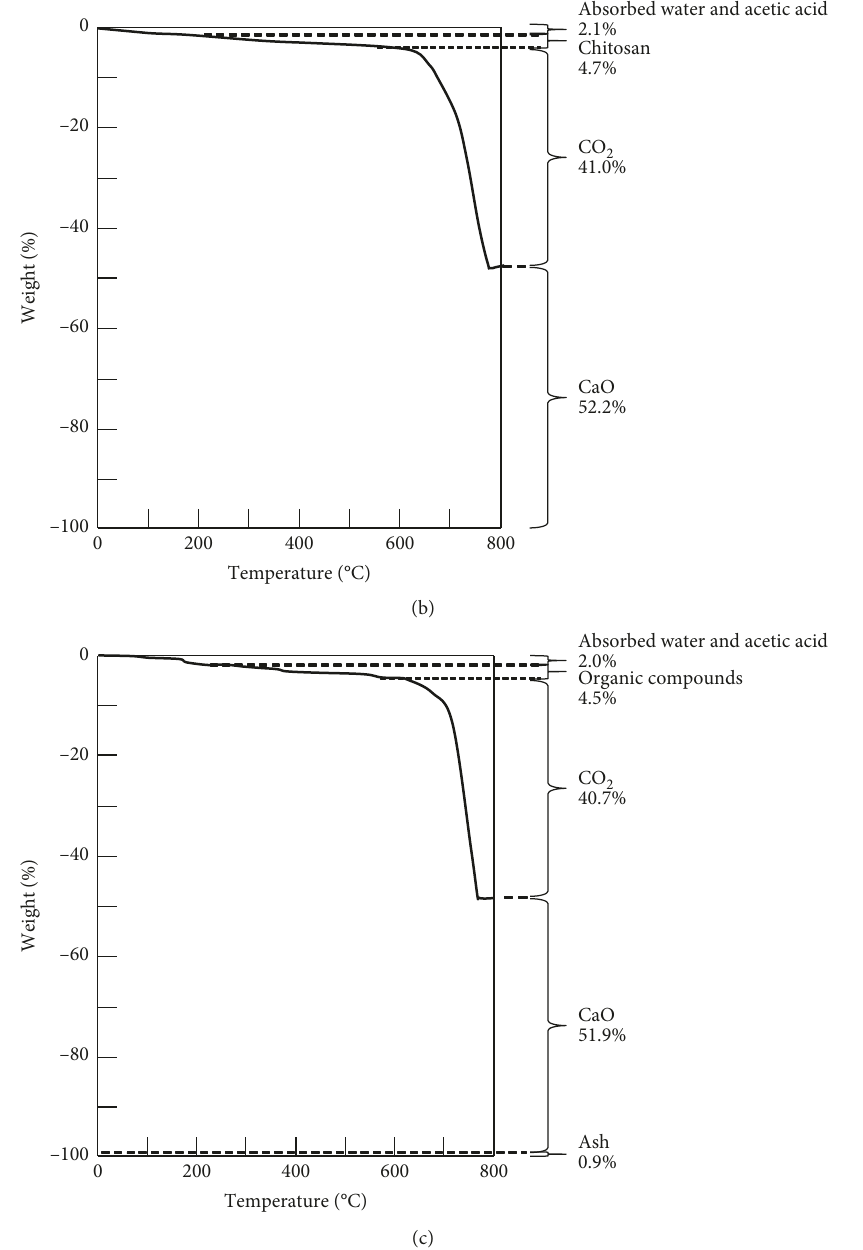
Figure 3: Thermogravimetric analysis of molded composites fabricated by means of the hydrothermal hot pressing method from (a) CaCO 3 -chitosan composite prepared at 4 ° C, (b) CaCO 3 -chitosan composite prepared at 95 ° C, and (c) milled scallop